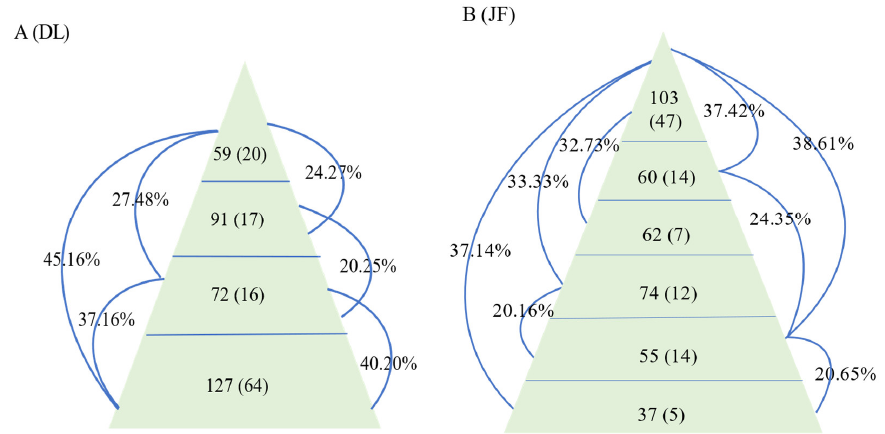
Figure 2. Counts of total OTUs and unique OTUs (in brackets) found at each altitude and the percentages of unique OTUs at different altitudes on Mt. Diaoluo ( A ) and Mt. Jianfengling ( B ).